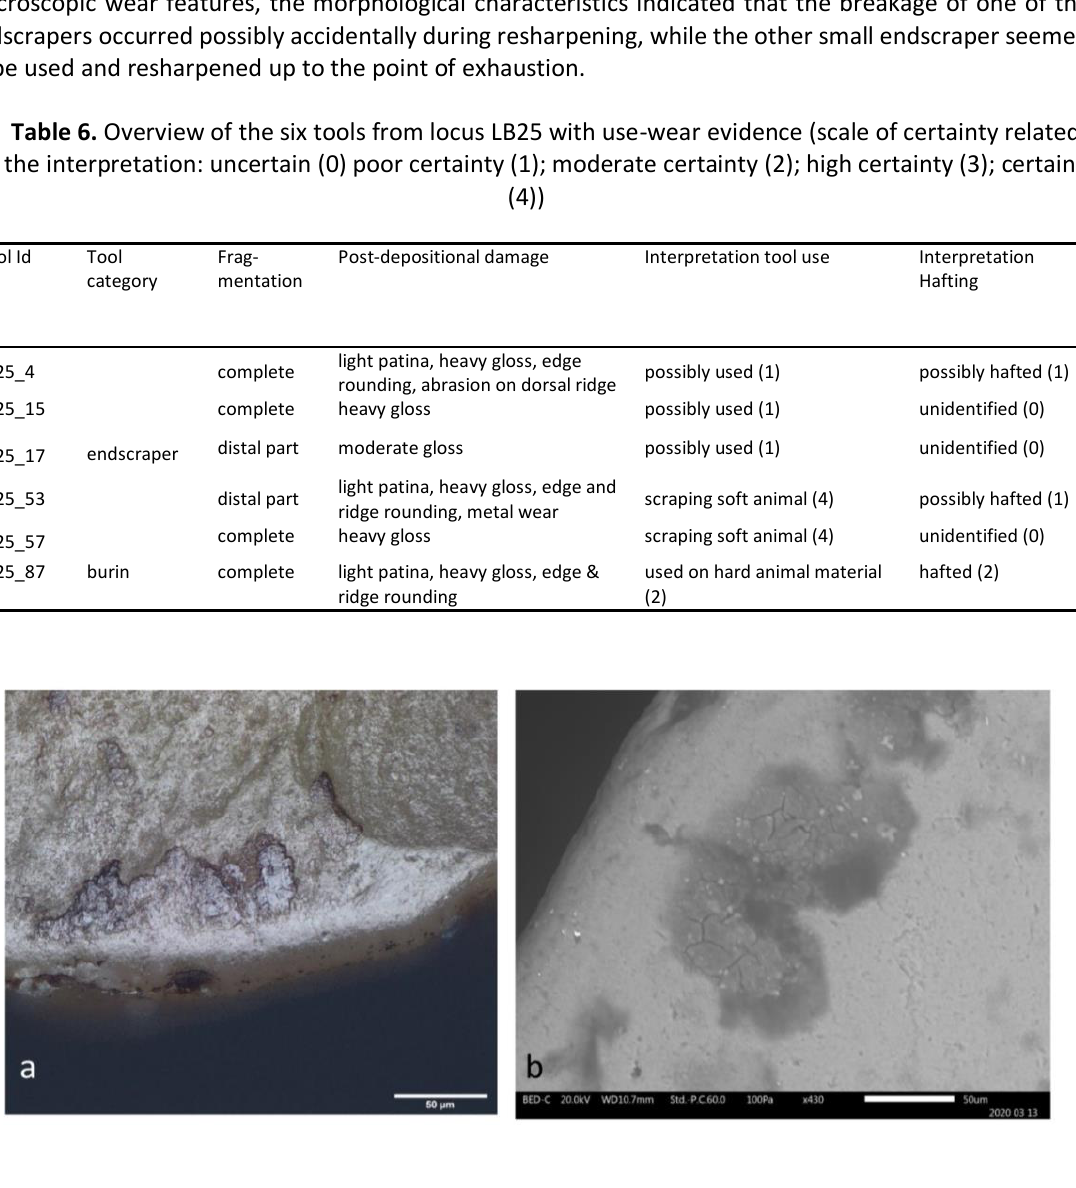
Figure 9. Endscraper LB25_53 interpreted as being used on soft animal material: a) microscopic detail of well-pronounced rounding from use on the distal ventral right edge of the scraper, with the additional presence of a black smeared organic residual deposition (200x); b) backscattered electron image showing a detail of the rounded distal ventral edge of the tool with adhering organic residual depositions (430x).